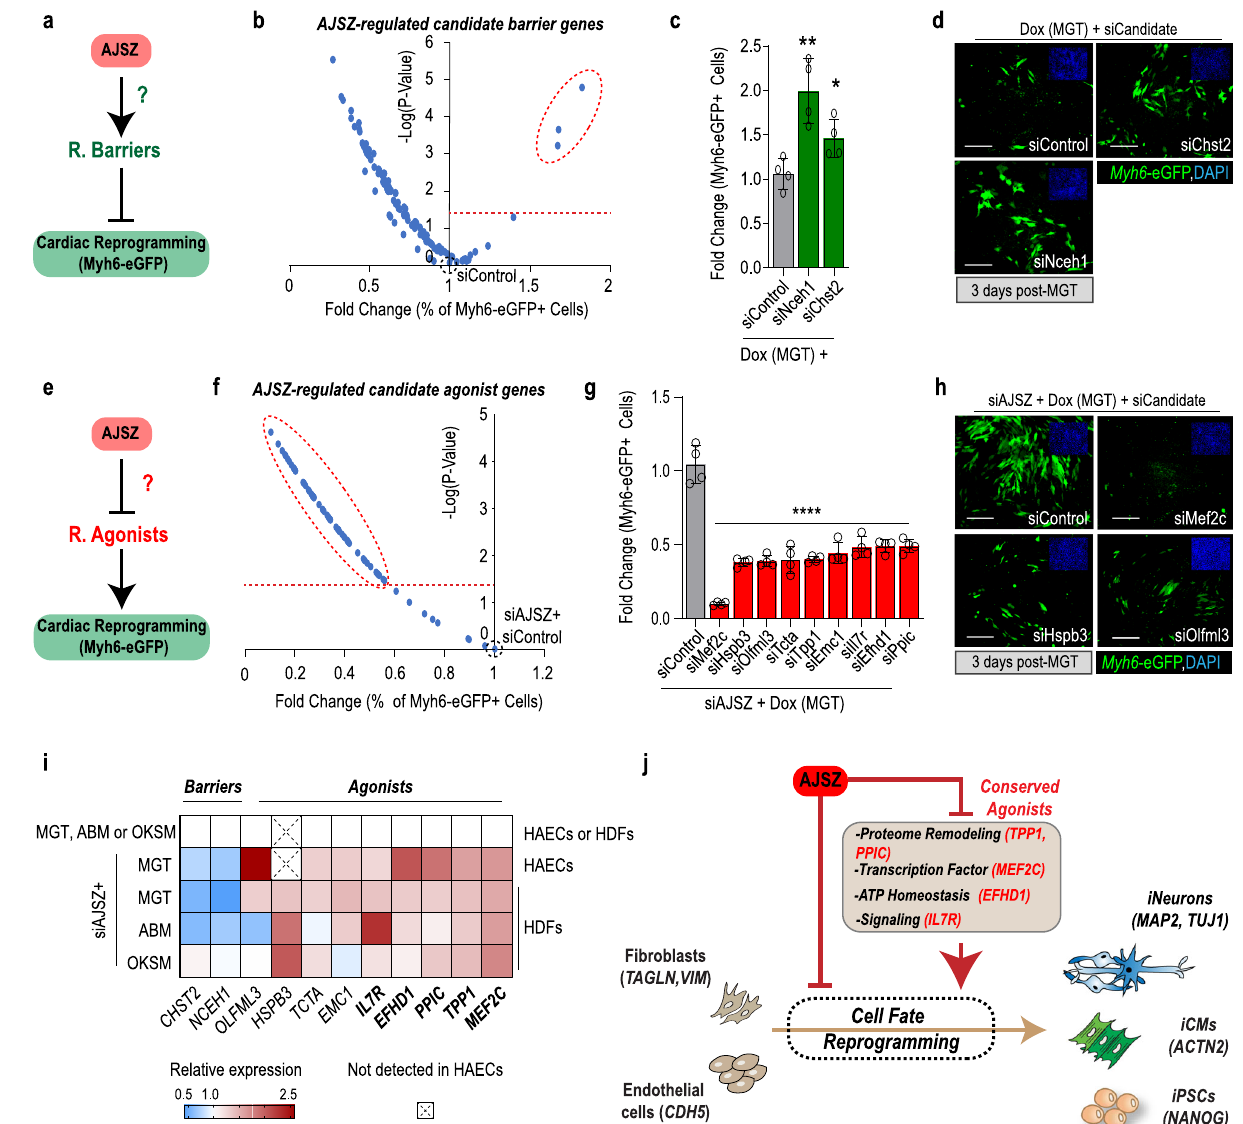
Fig. 6 | AJSZ control reprogramming barriers and agonists expression. a Schematic depicting the hypothesis that AJSZ promotes the expression of reprogramming barriers. b Volcano plot showing the screening results for siRNAs directed against top 25 percentile downregulated (MGT+siAJSZ vs MGT) and core promoter-bound genes inthe iMGT-MEFCR assay. The topthree candidate barrier genes are circled. n =4 per condition. c Histogram showing validation of siNceh1 and siChst2 effect on CR. n =8 per condition. d Representative images for siCon- trol, siChst2, and siNceh1 conditions. Myh6-eGFP+ cells are shown in green and cell nuclei are stained blue (DAPI, top right insets). e Schematic depicting the hypothesis that AJSZ negatively regulates reprogramming agonists. f Volcano plot showing the screening results for siRNAs directed against the top 25 percentile of upregulated(MGT+siAJSZ vs MGT)and core promoter-bound genes